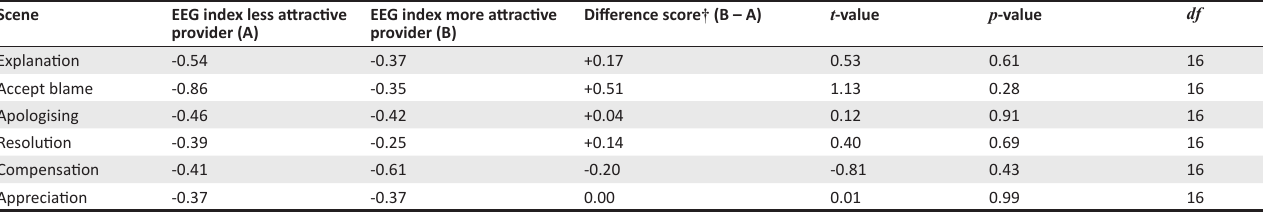
TABLE 7: Male respondents: A comparison of electroencephalography responses to attractiveness of female service provider. Scene EEG index less attractive provider (A)